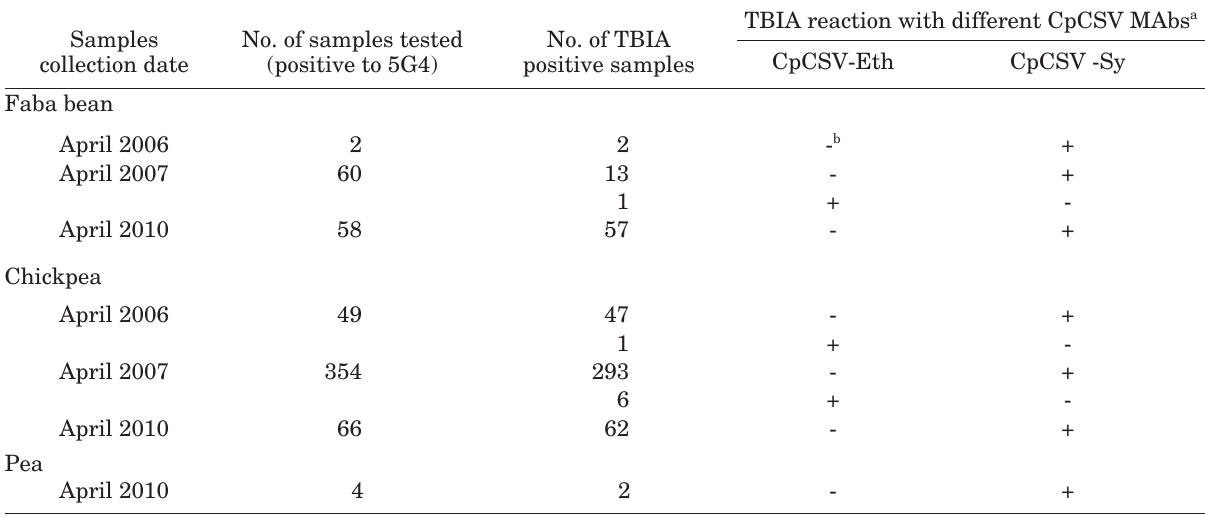
Table 2. Results of TBIA reaction with two CpCSV MAbs of plant samples collected during April 2006, 2007 and 2010 from different regions of Tunisia. Samples collection